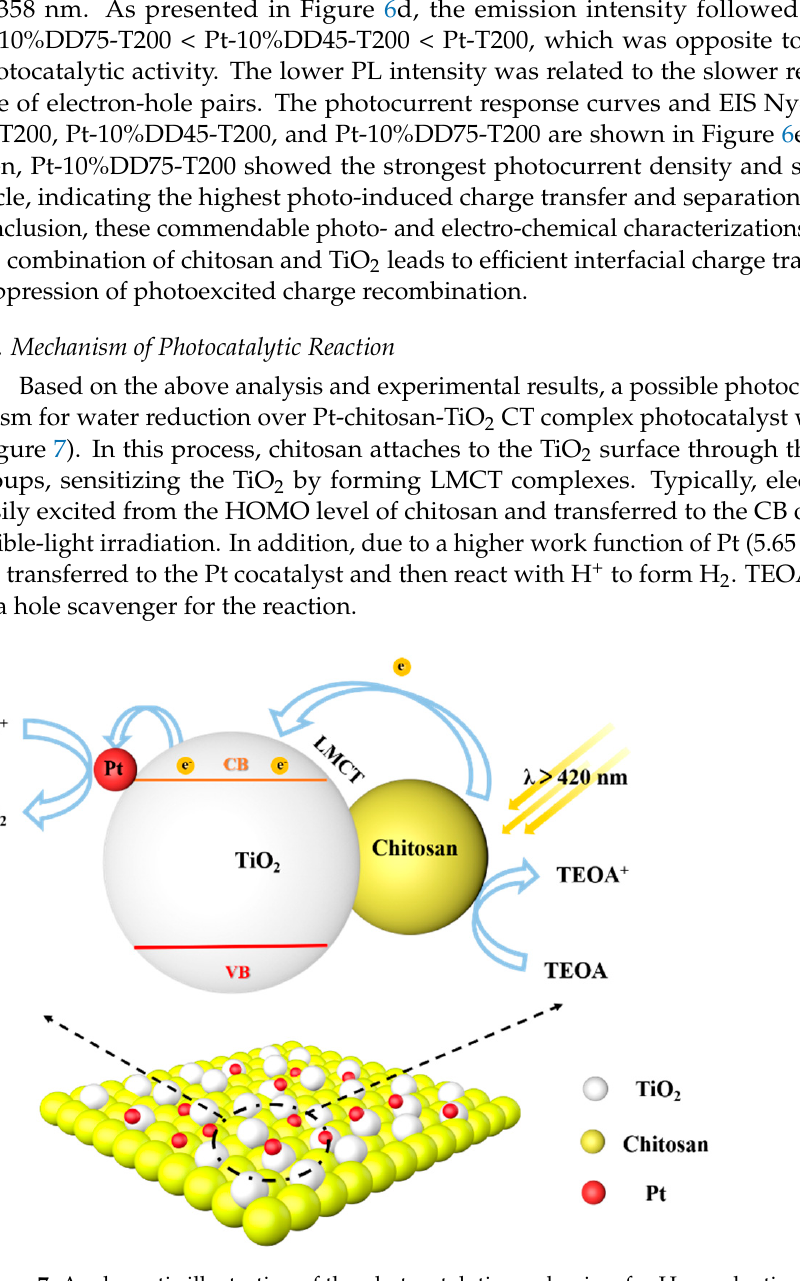
Figure 7. A schematic illustration of the photocatalytic mechanism for H 2 production through water reduction over a Pt-chitosan-TiO 2 charge transfer complex.